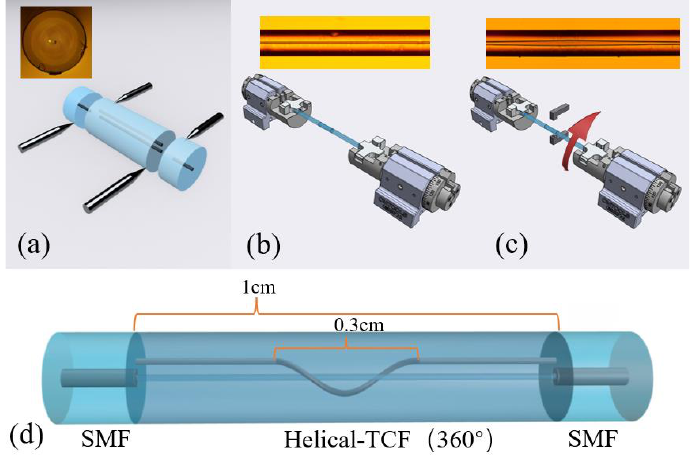
Figure 1. The production process for the sensing structure. ( a ) TCF is subjected to fusion spliced with SMF. ( b ) Keep fiber straight. ( c ) Twist and heat the TCF. ( d ) Schematic diagram of sensing structure (360 ◦